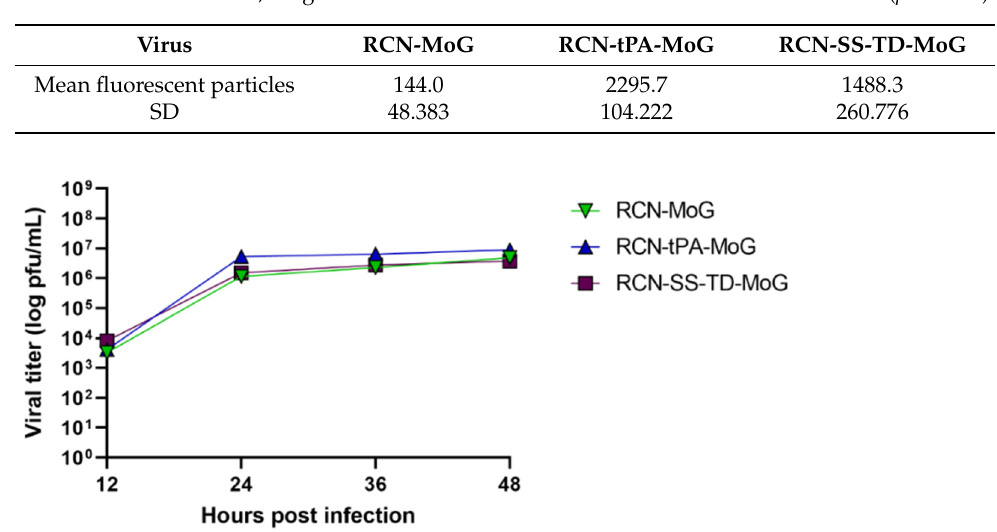
Figure 2. Immunofluorescence of raccoonpox constructs RCN-MoG, RCN-tPA-MoG, and RCN-SS- TD-MoG expressing mosaic lyssavirus phylogroup I glycoprotein (MoG) 24 h after infection. RCN expressing green fluorescent protein (GFP) and a well of uninfected cells (Cell control) were used as negative controls. Table 1. Mean of fluorescent particles expressing MoG (with standard deviation), counted from images of immunofluorescence assays. RCN-tPA-MoG has the highest mean, followed by RCN-SS- TD-MoG and RCN-MoG; a significant difference was detected between the three viruses ( p = 0.004).